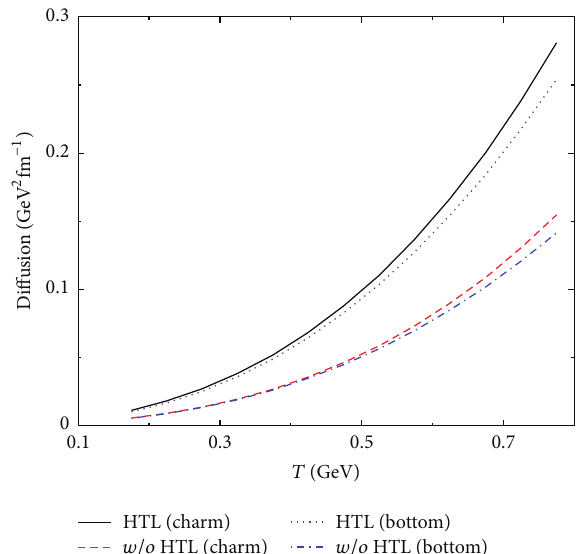
Figure 23: Variation of diffusion of heavy quarks of momentum 1GeV with temperature (color